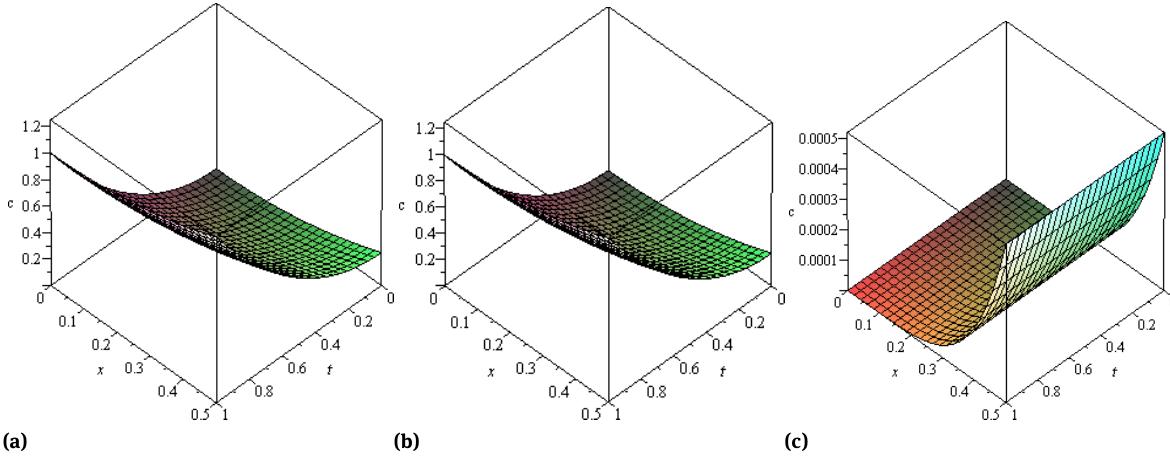
Fig. 4: The surfaces show solution c ( x , t ) for Eq. (32) at (cid:126) = −1, n = 1 and β = 1 : (a) Exact solution; (b) 3rd order q -FHATM approximate solution; (c) 3rd order absolute error.